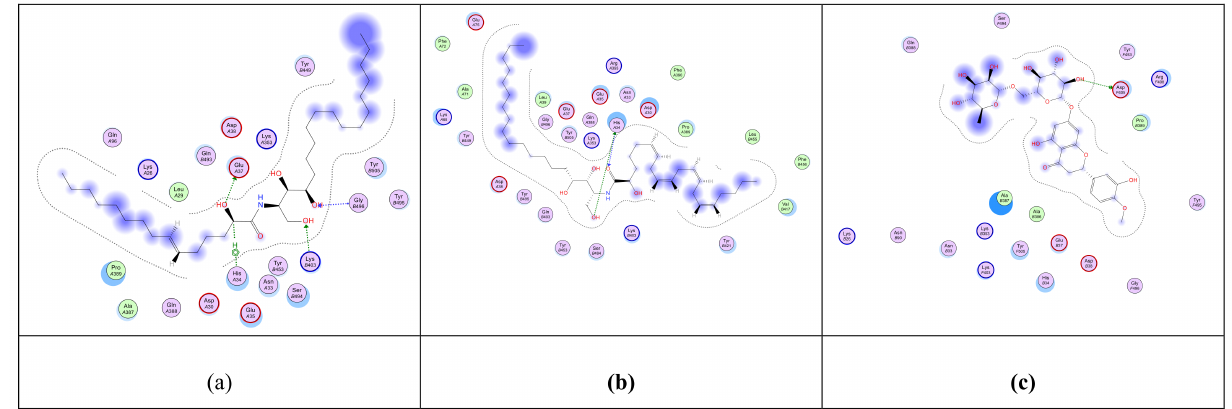
Figure 2. 2D representation of the docking of compounds Cer-5 ( a ); Cer-4 ( b ); and hesperidin ( c ) into the SARS-CoV-2 spike binding site with hACE2.